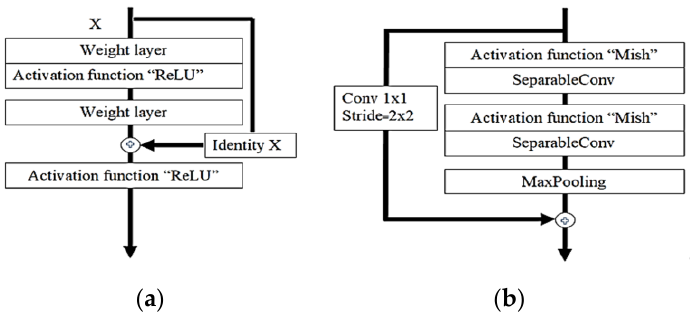
Figure 9. Residual connection diagram procedure showing ( a ) the residual connections of ResNet architecture; ( b ) Xception used residual connection to avoid the problem of vanishing gradients.